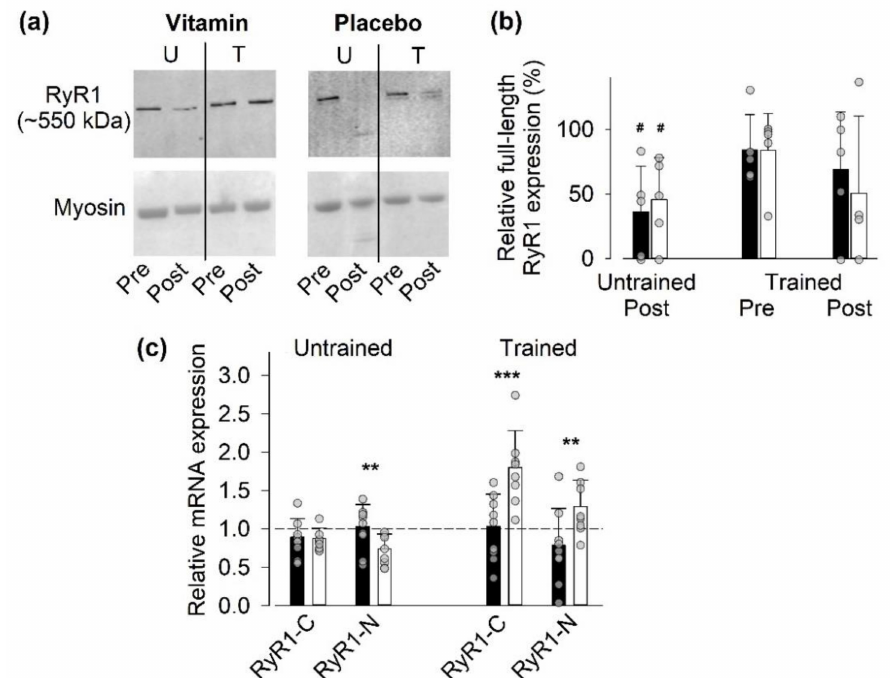
Figure 3. Vitamin-treatment-blunted SIT-induced changes in RyR1 mRNA expression in the trained state. ( a ) Representative Western blots obtained in one vitamin- and one placebo-treated individual before (Pre) and 24 h after (Post) the first (untrained; U) and last (trained; T) SIT sessions. Note the decrease in full-length RyR1 expression in the untrained state in the vitamin-treated participant and a decrease in both the untrained and trained states in the placebo-treated participant. Lower panels show the myosin band in Coomassie-stained gels, which were used as loading controls. ( b ) The relative full-length RyR1 expression in individuals treated with vitamins ( n = 5) or placebo ( n = 4). Data are expressed relative to the expression before the first SIT session, which was set to 100% in each subject. No significant di ff erence between the vitamin and placebo groups at any time with two-way repeated measures ANOVA. # denotes significant di ff erence ( p < 0.05) from the untrained pre-exercise value. ( c ) The ratio of mRNA expression 1 h after to that before the first and last SIT sessions in the vitamin group ( n = 9) and placebo group ( n = 7); dashed line indicates no di ff erence between before and after exercise. Two-way repeated measures ANOVA showed a general group di ff erence ( p < 0.01) in the trained state. Di ff erence between vitamin and placebo groups in relative mRNA expression of individual genes: ** p < 0.01, *** p < 0.001. Data are shown as mean ± SD; vitamin group, black bars; placebo group, white bars. Data from individual participants are shown as grey